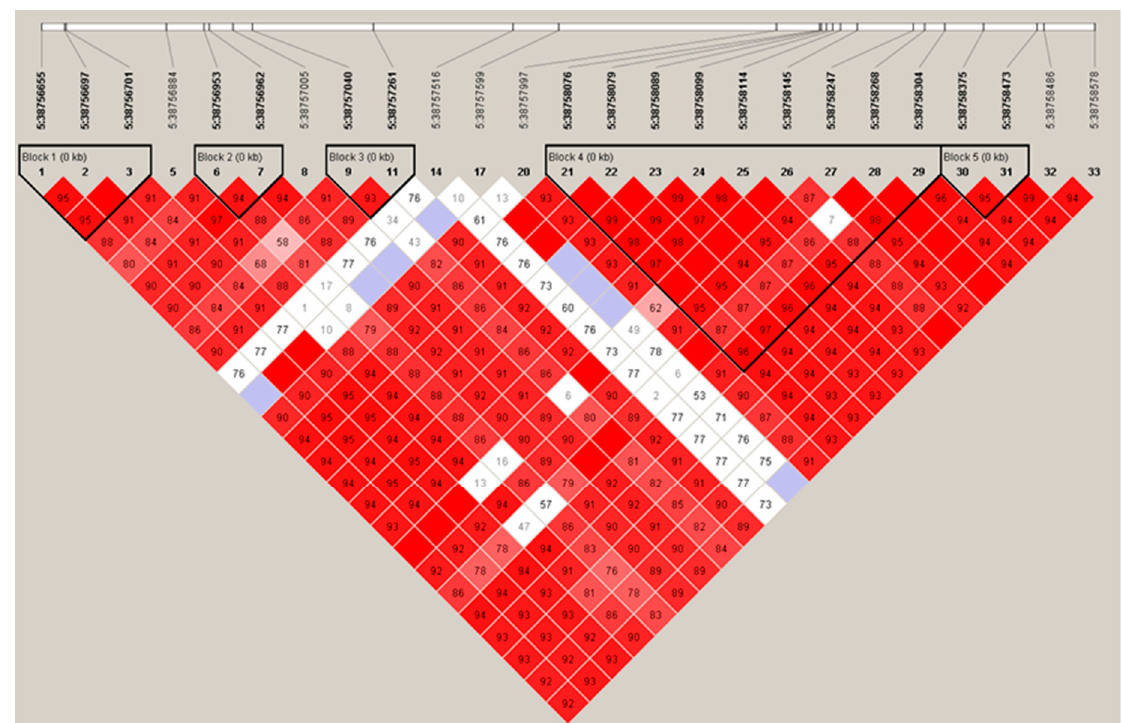
Figure 3. Linkage disequilibrium (LD) analysis of SNPs on promoter of GLIPR1 ; r 2 is the correlation coefficient between the two